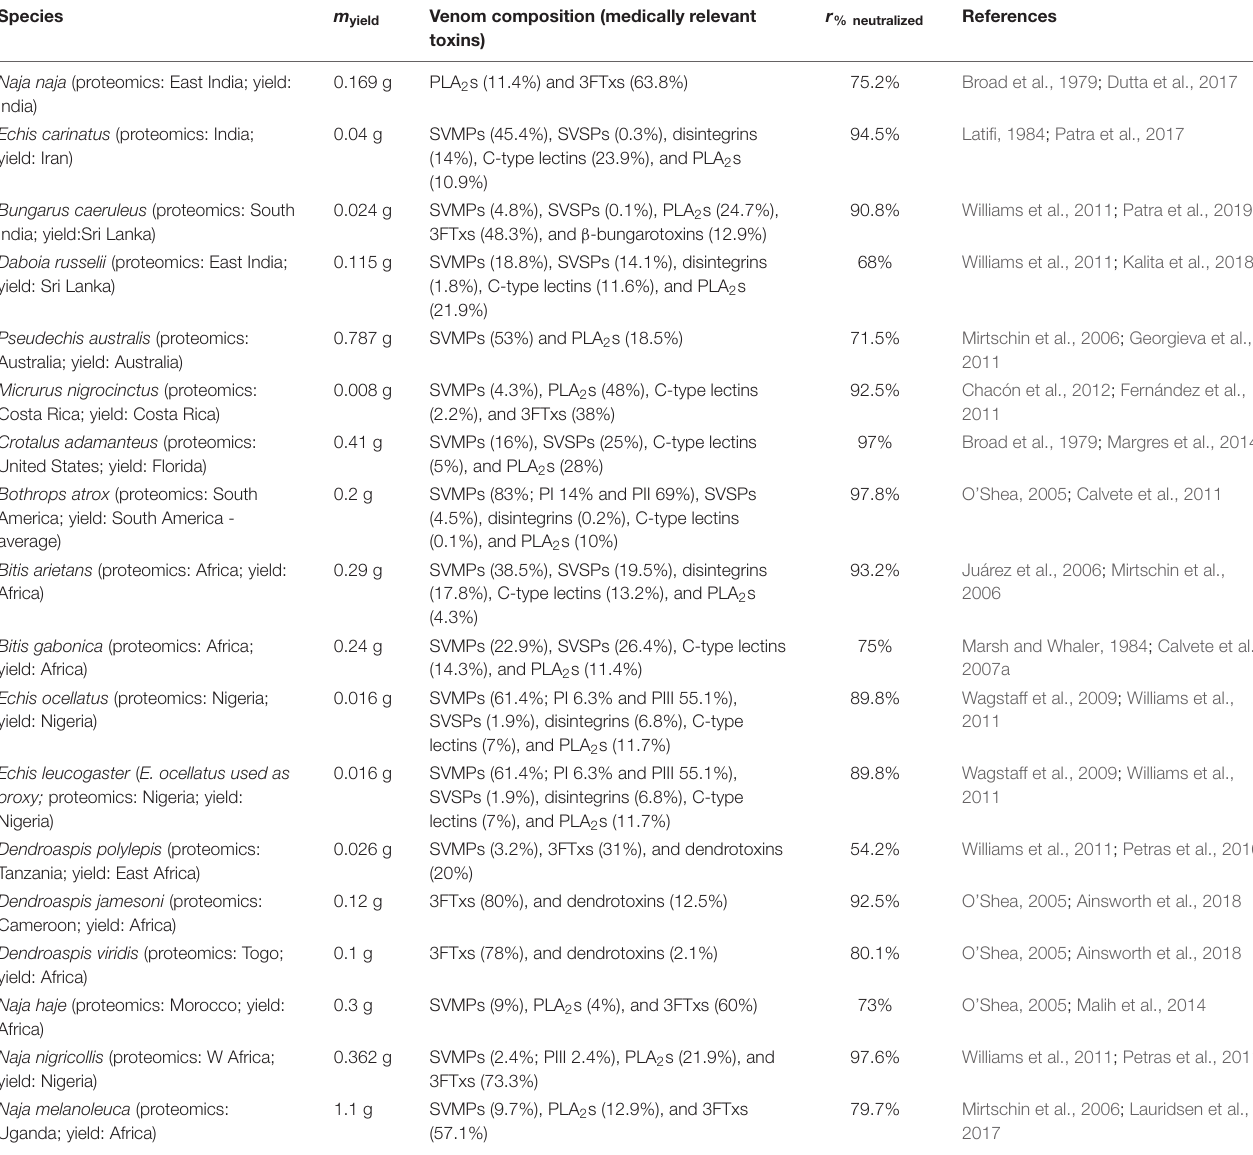
TABLE 1 | Venoms Included in Our Costing Analyses for Recombinant Antivenoms. Species m yield Venom composition (medically relevant